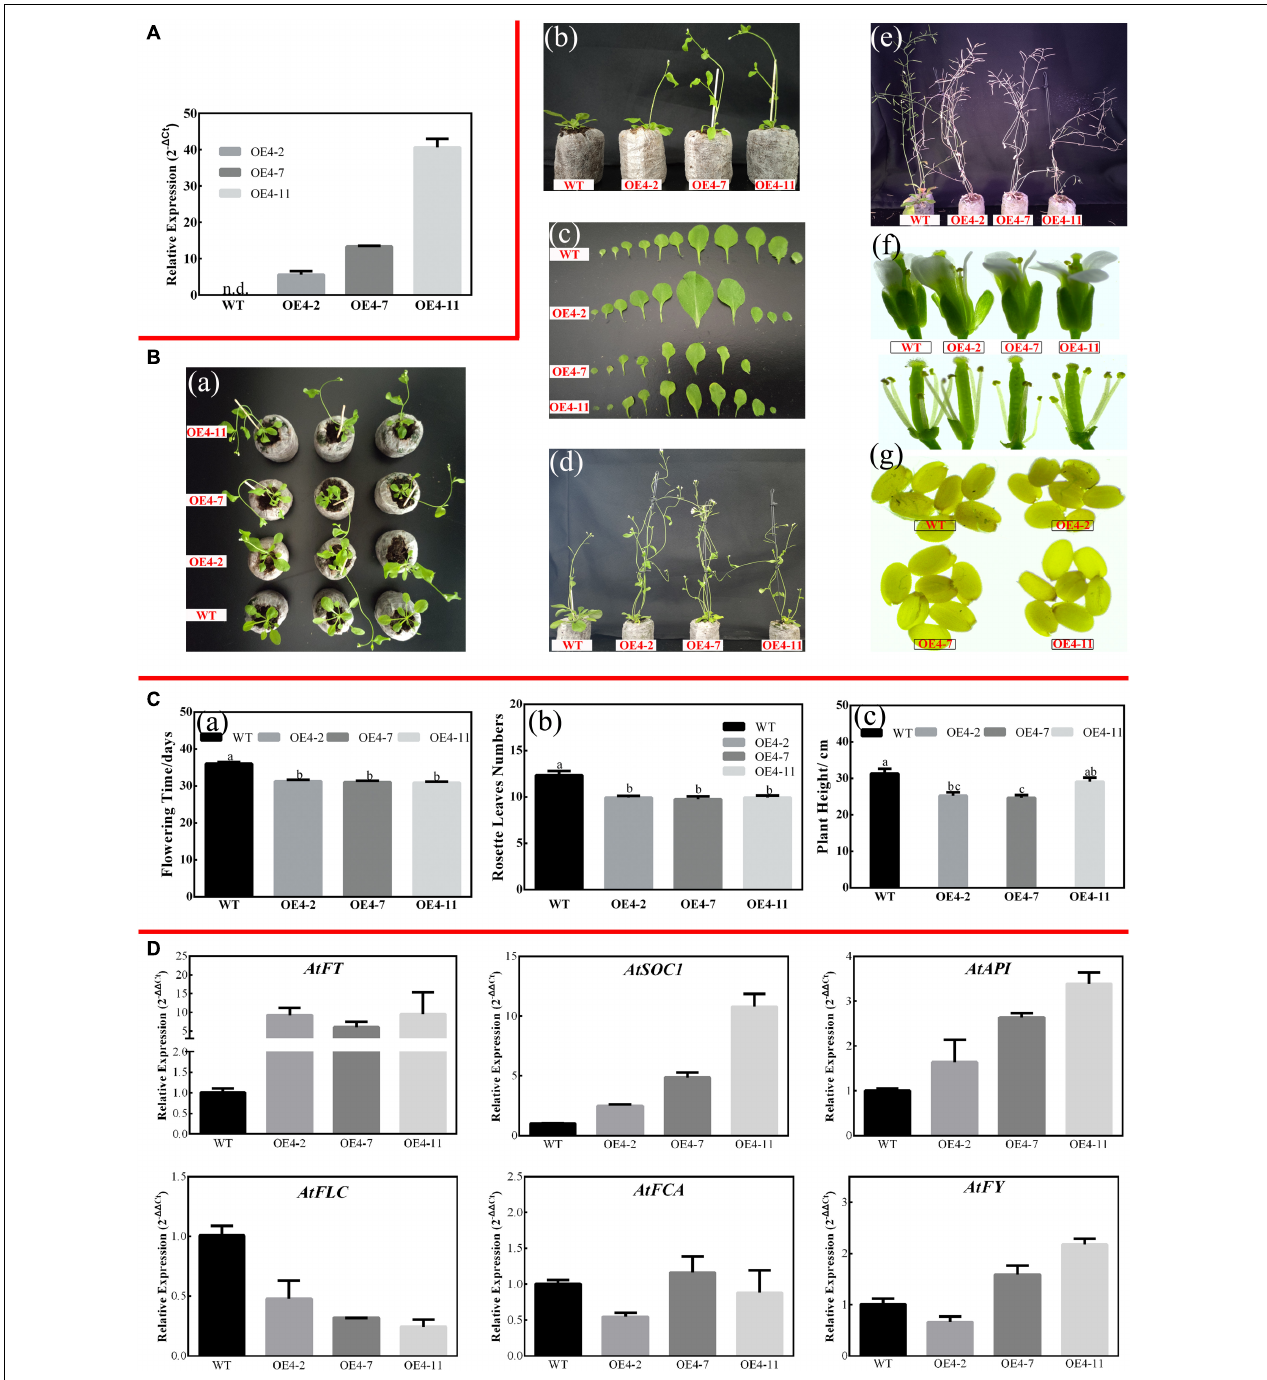
FIGURE 5 | Overexpression of CsPMEI4 promotes early flowering in transgenic Arabidopsis under LD condition. (A) The expression of CsPMEI4 in three CsPMEI4 -OE lines and WT plants. The relative expression levels were calculated by using 2 - (cid:49) Ct method. Data are shown as the means ± SE ( n = 3). (B) Early flowering phenotypes of CsPMEI4 -OE lines grown under LD condition. (a) Early-flowering phenotype; (b) phenotypes of CsPMEI4 -OE lines and WT plants after 30 d of growth under LD condition; (c) leaf size; (d) phenotype of CsPMEI4 -OE lines and WT plants after 40 days of growth under LD condition; (e) phenotype of CsPMEI4 -OE lines and WT plants at senescence stage; (f) flowers sizes of WT and CsPMEI4 -OE lines; (g) seed size of WT and CsPMEI4 -OE lines. (C) Flowering time, rosette leaves numbers, and plant height of WT and CsPMEI4 -OE lines at the just bolting stage. (a) Flowering time; (b) rosette leaves numbers; (c) plant height. (D) Expression analysis of flowering-related genes. The final results were calculated with 2 - (cid:49) (cid:49) Ct method. Data are shown as the means ± SE ( n = 3).